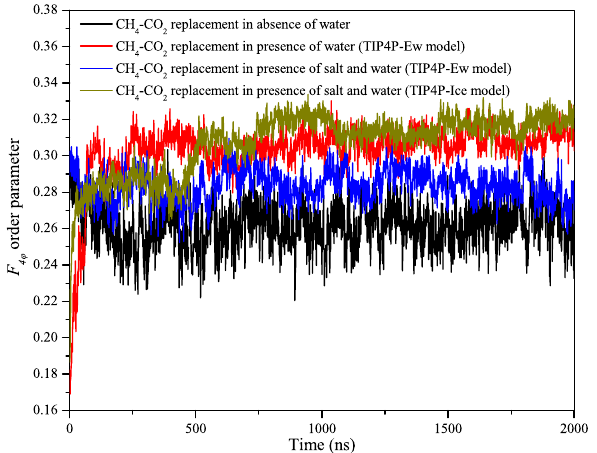
Figure 9. F 4φ order parameter for the CH 4 –CO 2 replacement in absence and presence of water and salt ions at 260 K and 50